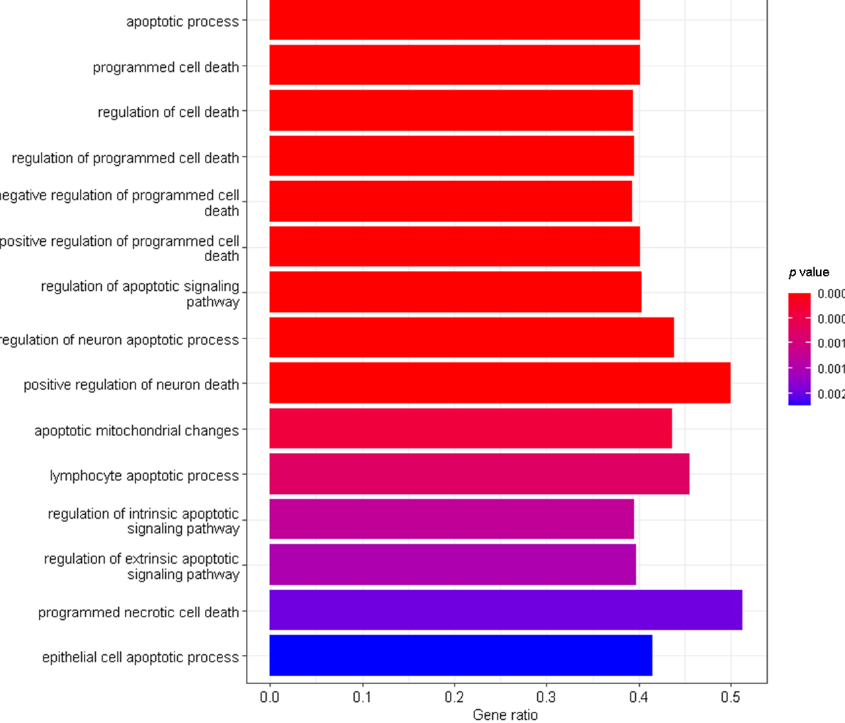
Figure 3. Cell death and apoptosis pathways significantly enriched among genes with significant strain × treatment interactions. Enrichment of Gene Ontology terms was quantified in order to identify over-represented categories of biological processes for our genes that showed a significant strain × treatment interaction. Numerous gene ontology pathways related to cell death and apoptosis were identified and representative pathways are shown. Enrichment analysis was performed using tools available at WebGestalt (www.webgestalt.org), with FDR adjp < 0.05. The y-axis lists significant biological processes related to cell death and apoptosis. The x-axis shows the ratio of the number of genes that were detected in our analysis to the total number of genes in each category.